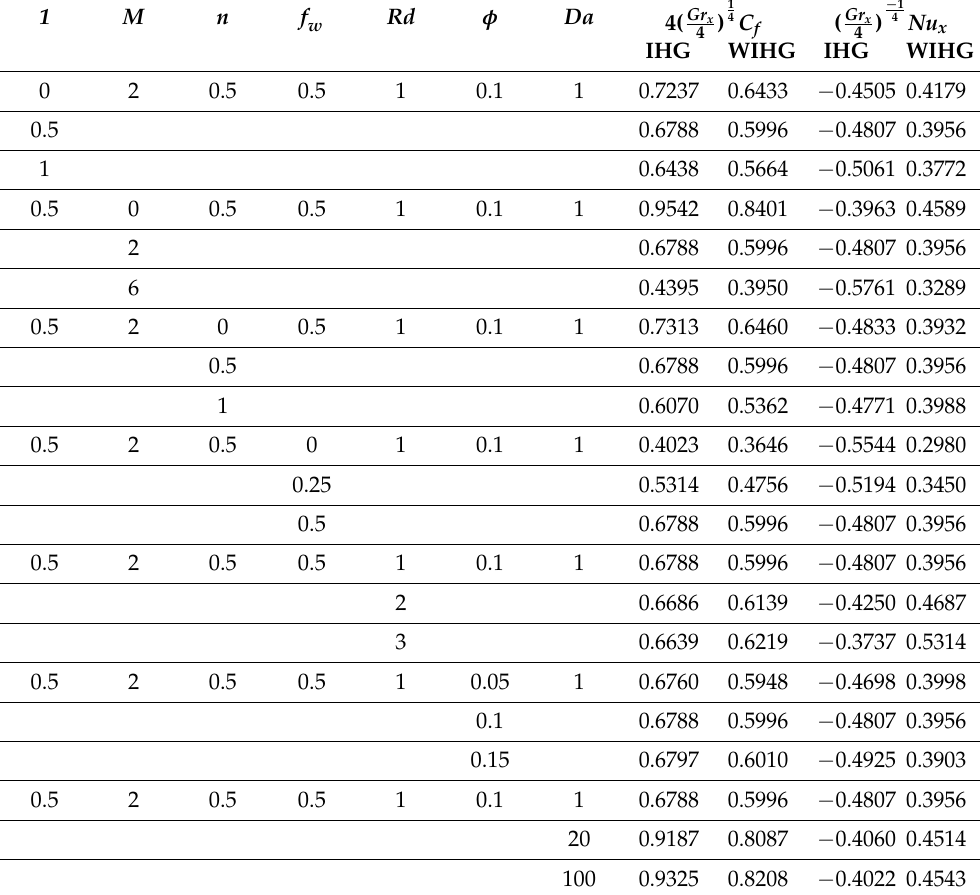
Table 3. Skin friction coefficient and the Nusselt number for various values of R , M , n , f w , Rd , φ and Da at λ = 0.5, B =